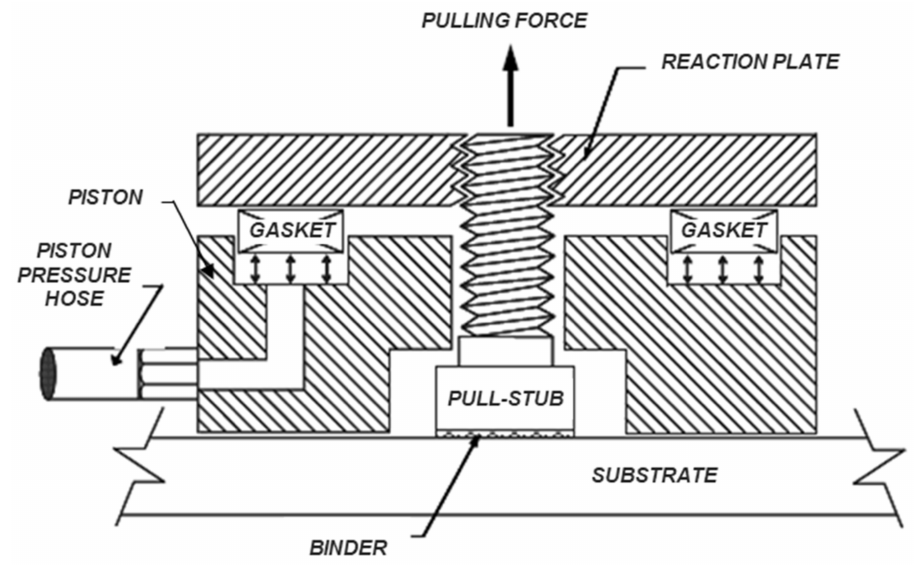
Figure 7. Schematic cross-section of BBS test device.